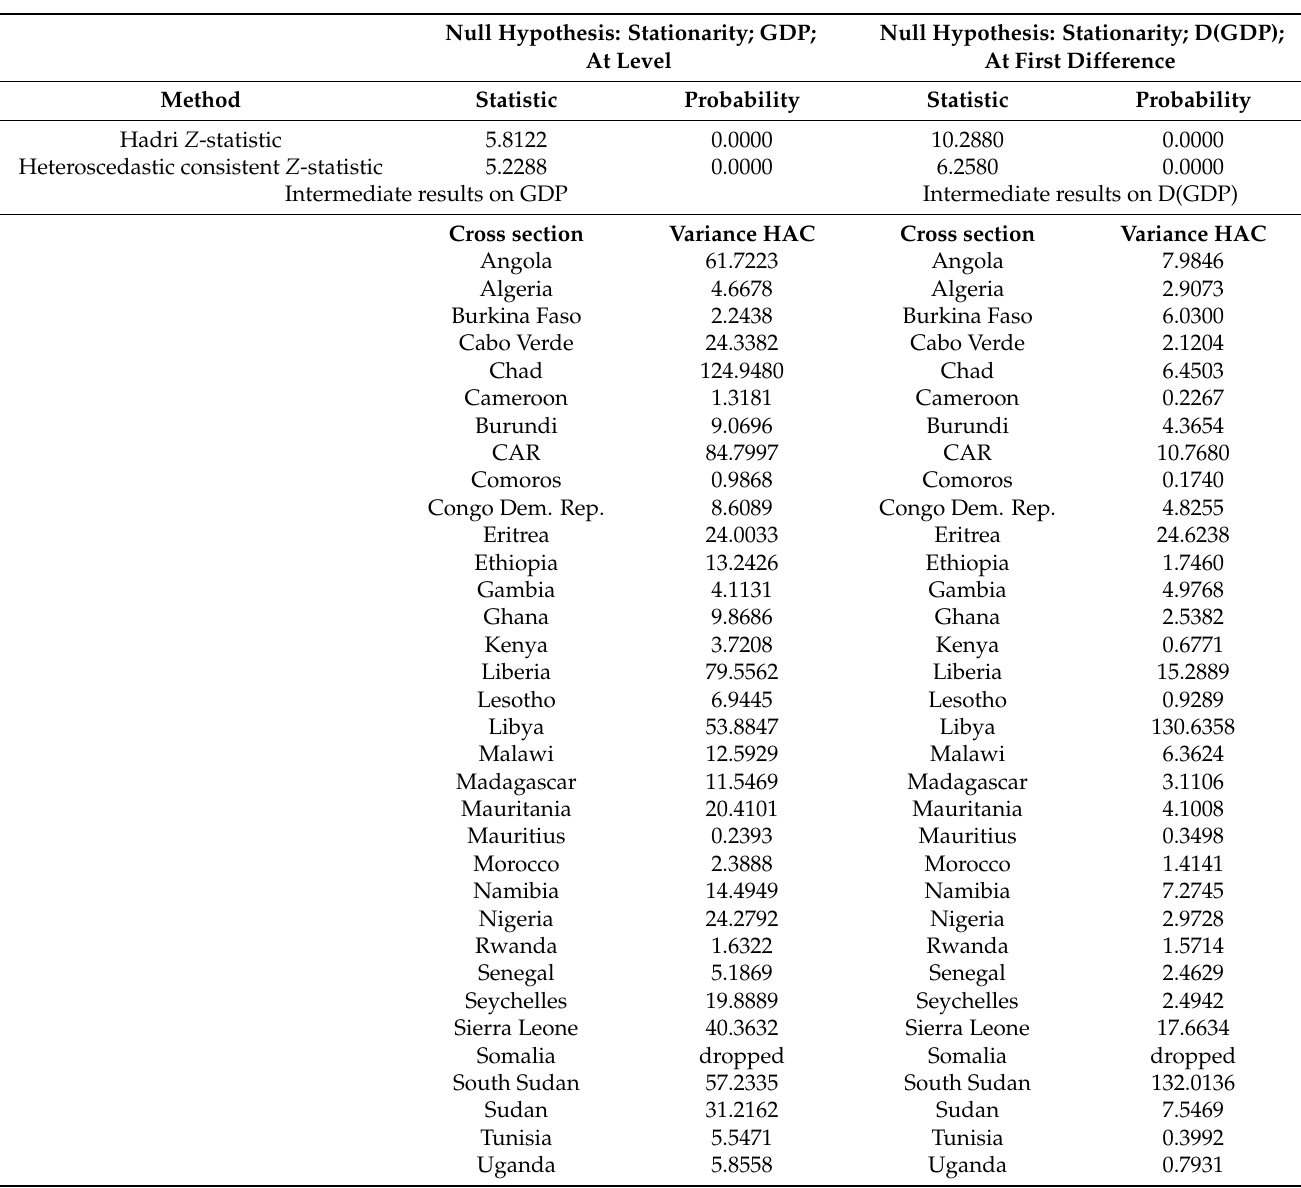
Table 5. Hadri test for